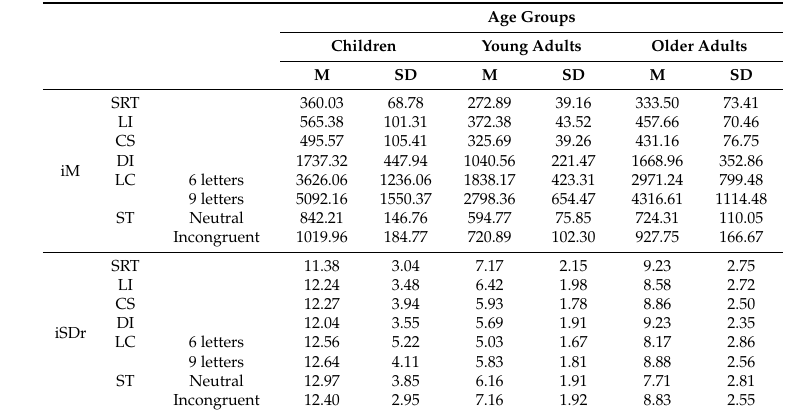
Table 3. Reaction time tasks: Means (iM) and intra-individual standard deviation of residual scores (iSDr) by Age